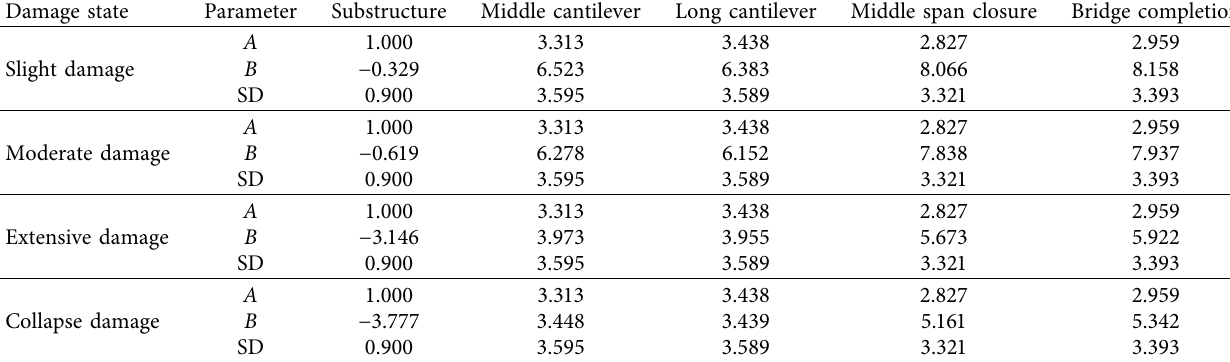
Table 6: Coefficients and standard deviations in the linear function fitting